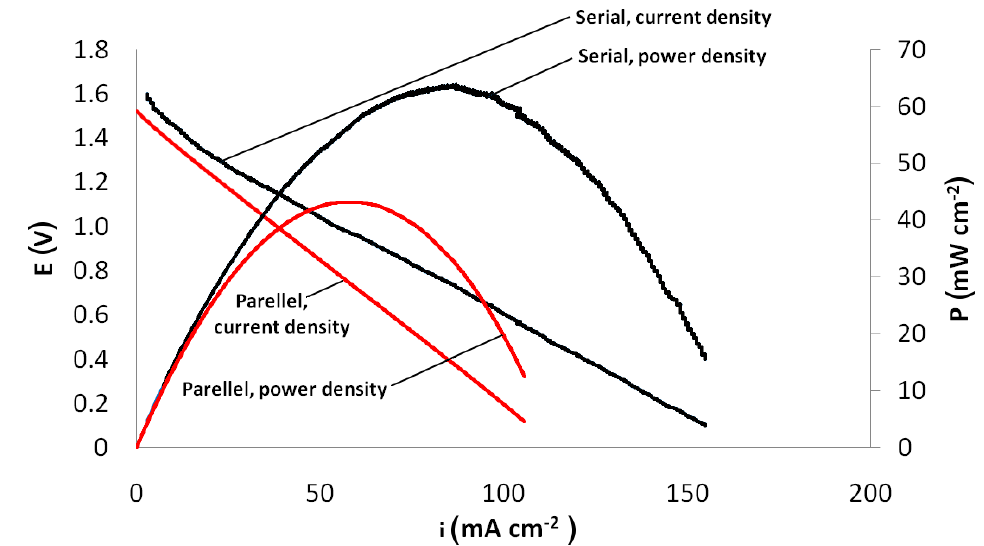
Figure 8. Polarization curves of two-cell stacks.